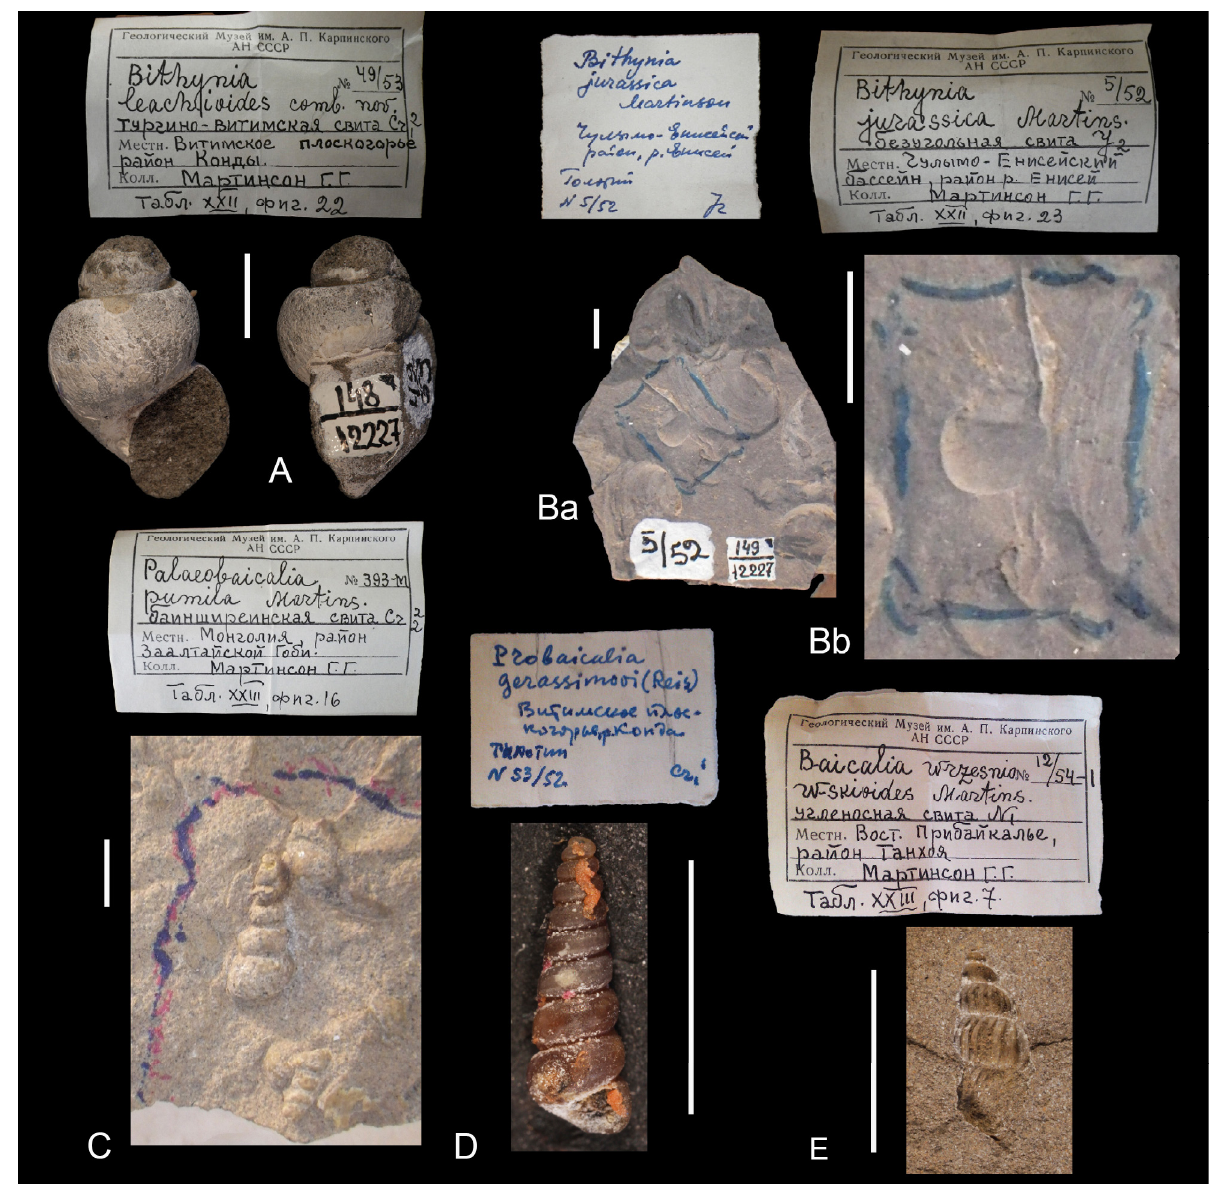
Figure 9. Some fossil representatives of ‘Bithyniidae’, Palaeobaicaliidae, and Baicaliidae with their museum labels. ( A ) Bythinia leachioides Martinson, 1961, holotype. ( Ba,Bb ) Bythinia jurassica Martinson, 1961, holotype. ( Ba ) Deposit with shell imprint. ( Bb ) the same, enlarged. ( C ) Palaeobaicalia pumila Martinson, 1961, holotype, the type species of the genus. ( D ) Probaicalia gerassimovi (Reis, 1910), topotype. ( E ) ‘ Baicalia’ wresniowskioides (Martinson, 1951). Scale bars 5 mm.